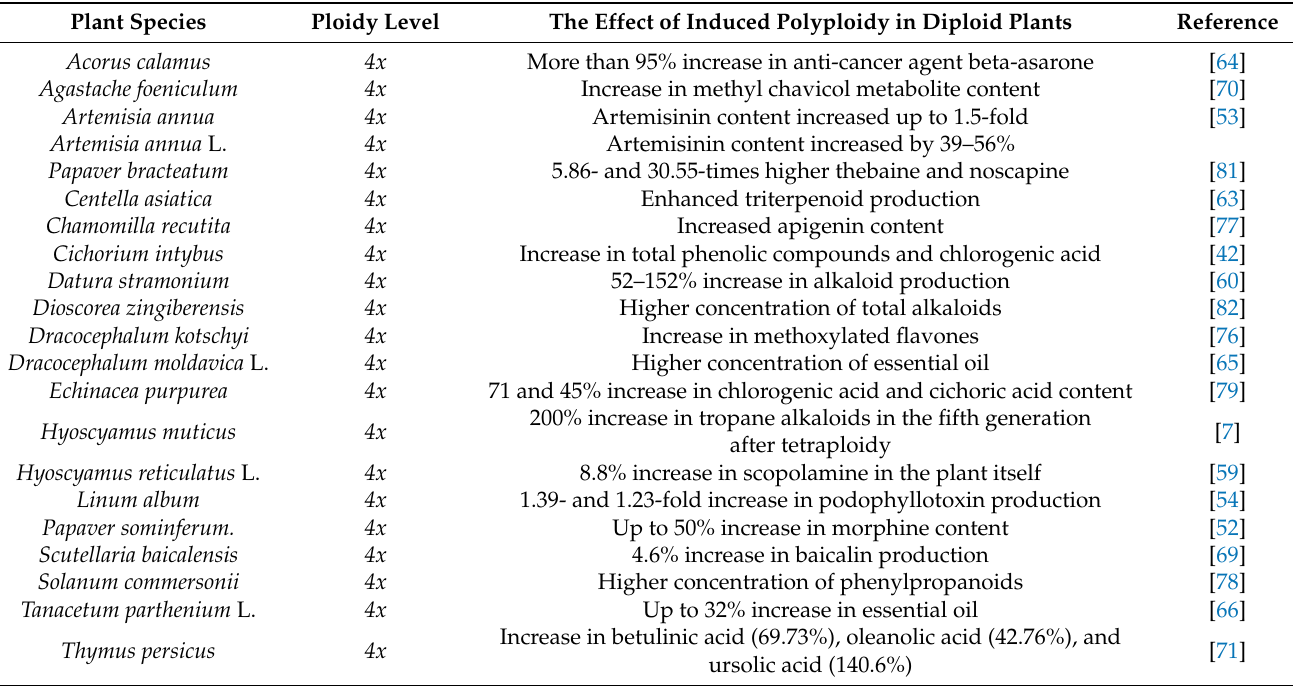
Table 1. Effect of ploidy level change on secondary metabolite